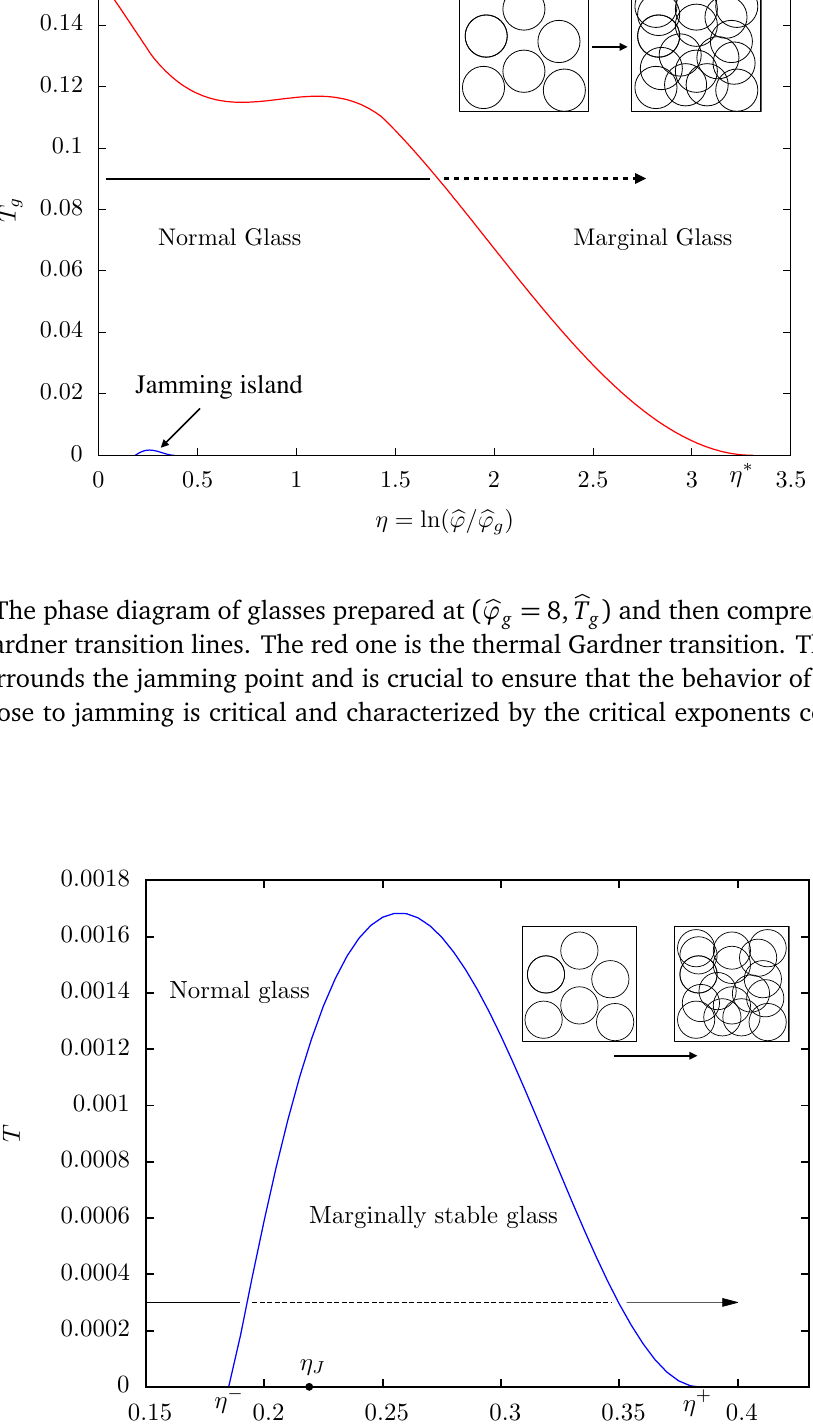
Figure 8: The Gardner transition line that surrounds the jamming point at of marginally stable glasses is what appears in Fig 7. Picture reprinted from [ 27 ]